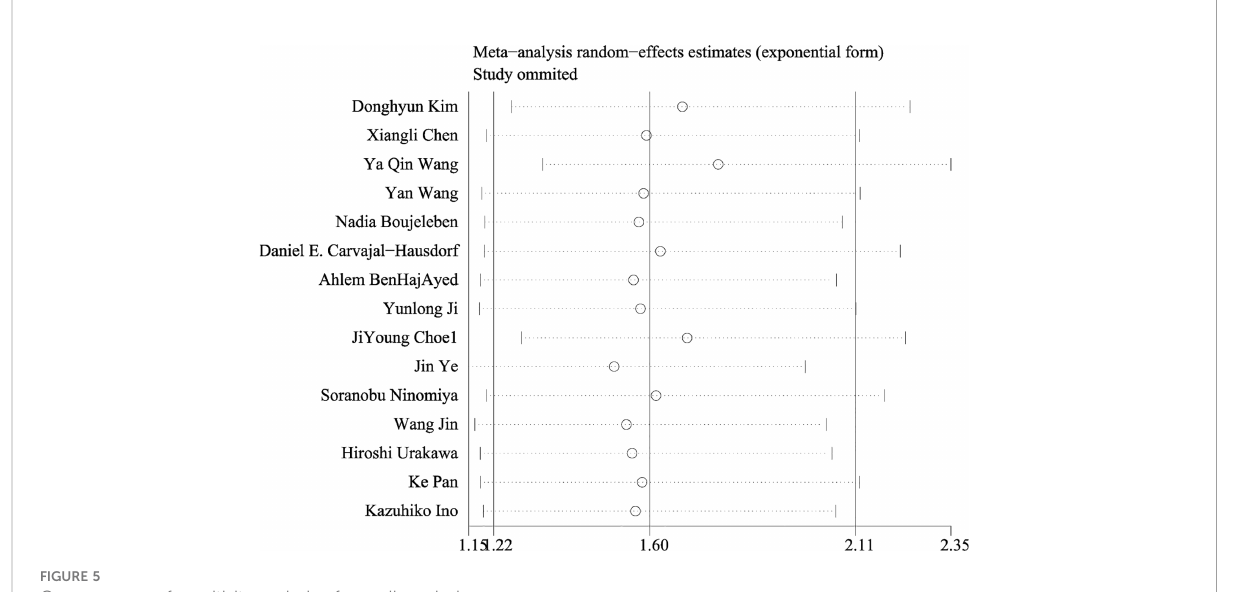
FIGURE 5 Consequence of sensitivity analysis of overall